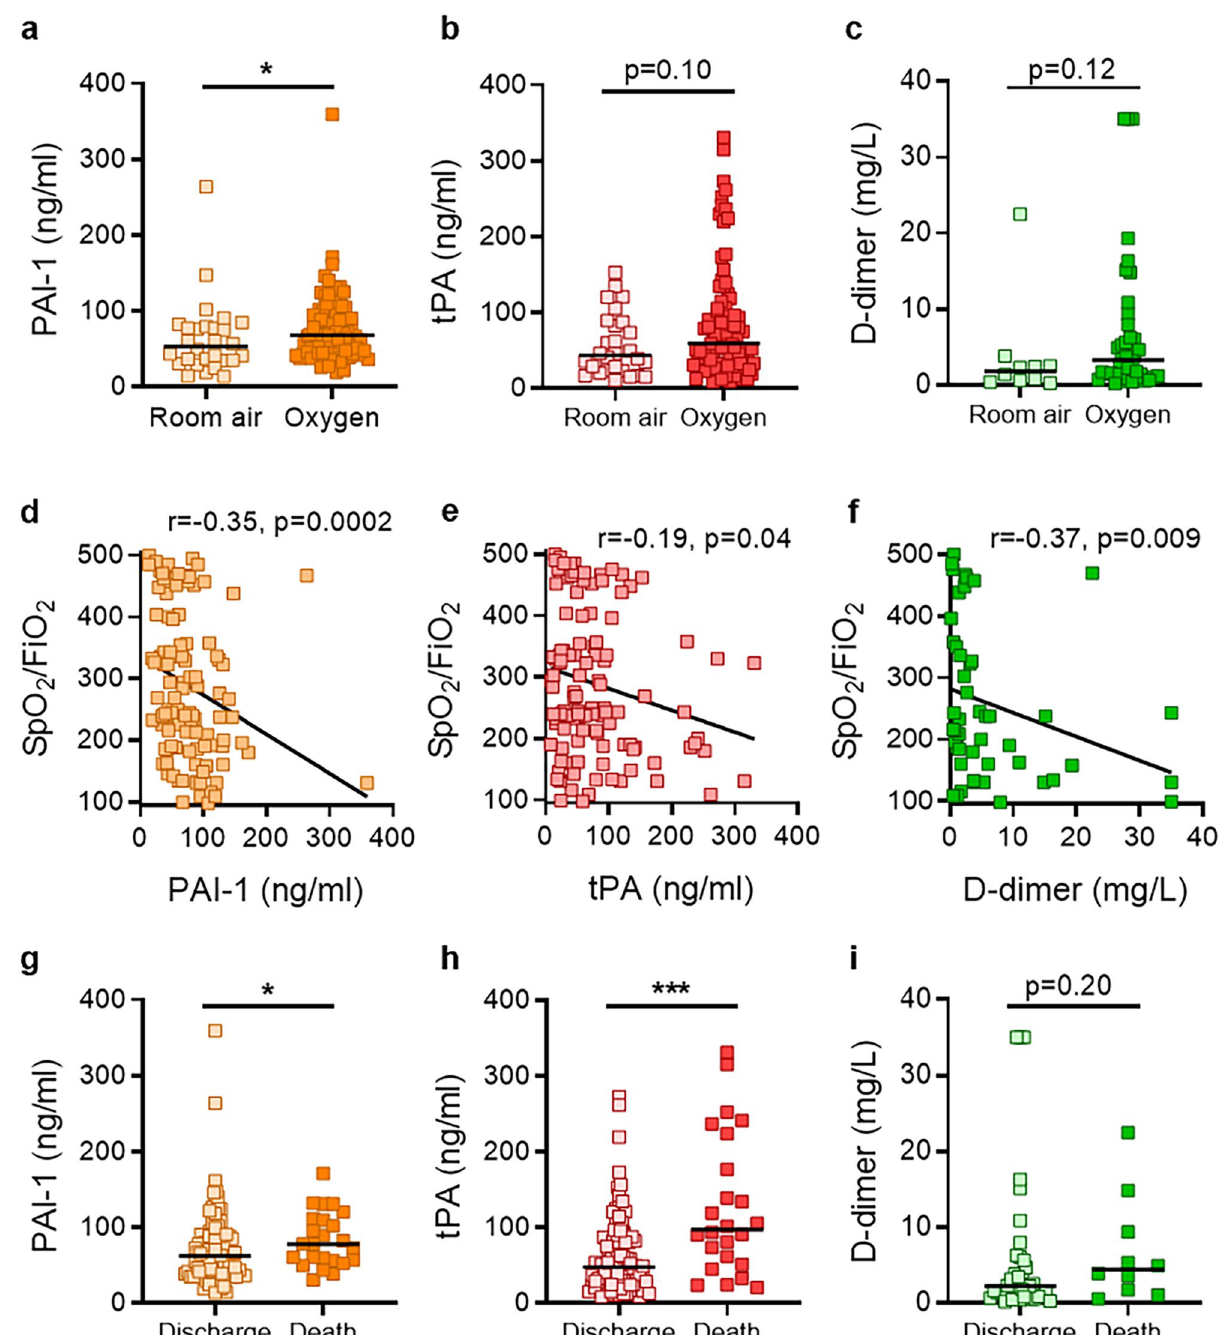
Figure 3. Association between PAI-1, tPA, D-dimer and respiratory status as well as final outcomes. ( a–c ) COVID-19 patients were grouped by clinical status (room air vs. supplemental oxygen) and analyzed for PAI-1, tPA, and D-dimer. Level of PAI-1, tPA, and D-dimer were not normally distributed based on Shapiro–Wilk test. Groups were compared by Mann–Whitney test; * p < 0.05. ( d–f ) PA1-1, tPA, and D-dimer were compared to SpO2/FiO2 ratio for each patient, and correlations were determined by Spearman’s test. ( g–i ) COVID-19 patients were also grouped by final outcomes (death vs. discharge). Level of PAI-1, tPA and D-dimer were not normally distributed based on Shapiro–Wilk test. Thus groups were compared by Mann–Whitney test; * p < 0.05, *** p < 0.001. Statistics were calculated and the figure was produced in GraphPad Prism https ://www.graph pad. com/scien tific -softw are/prism /, using version